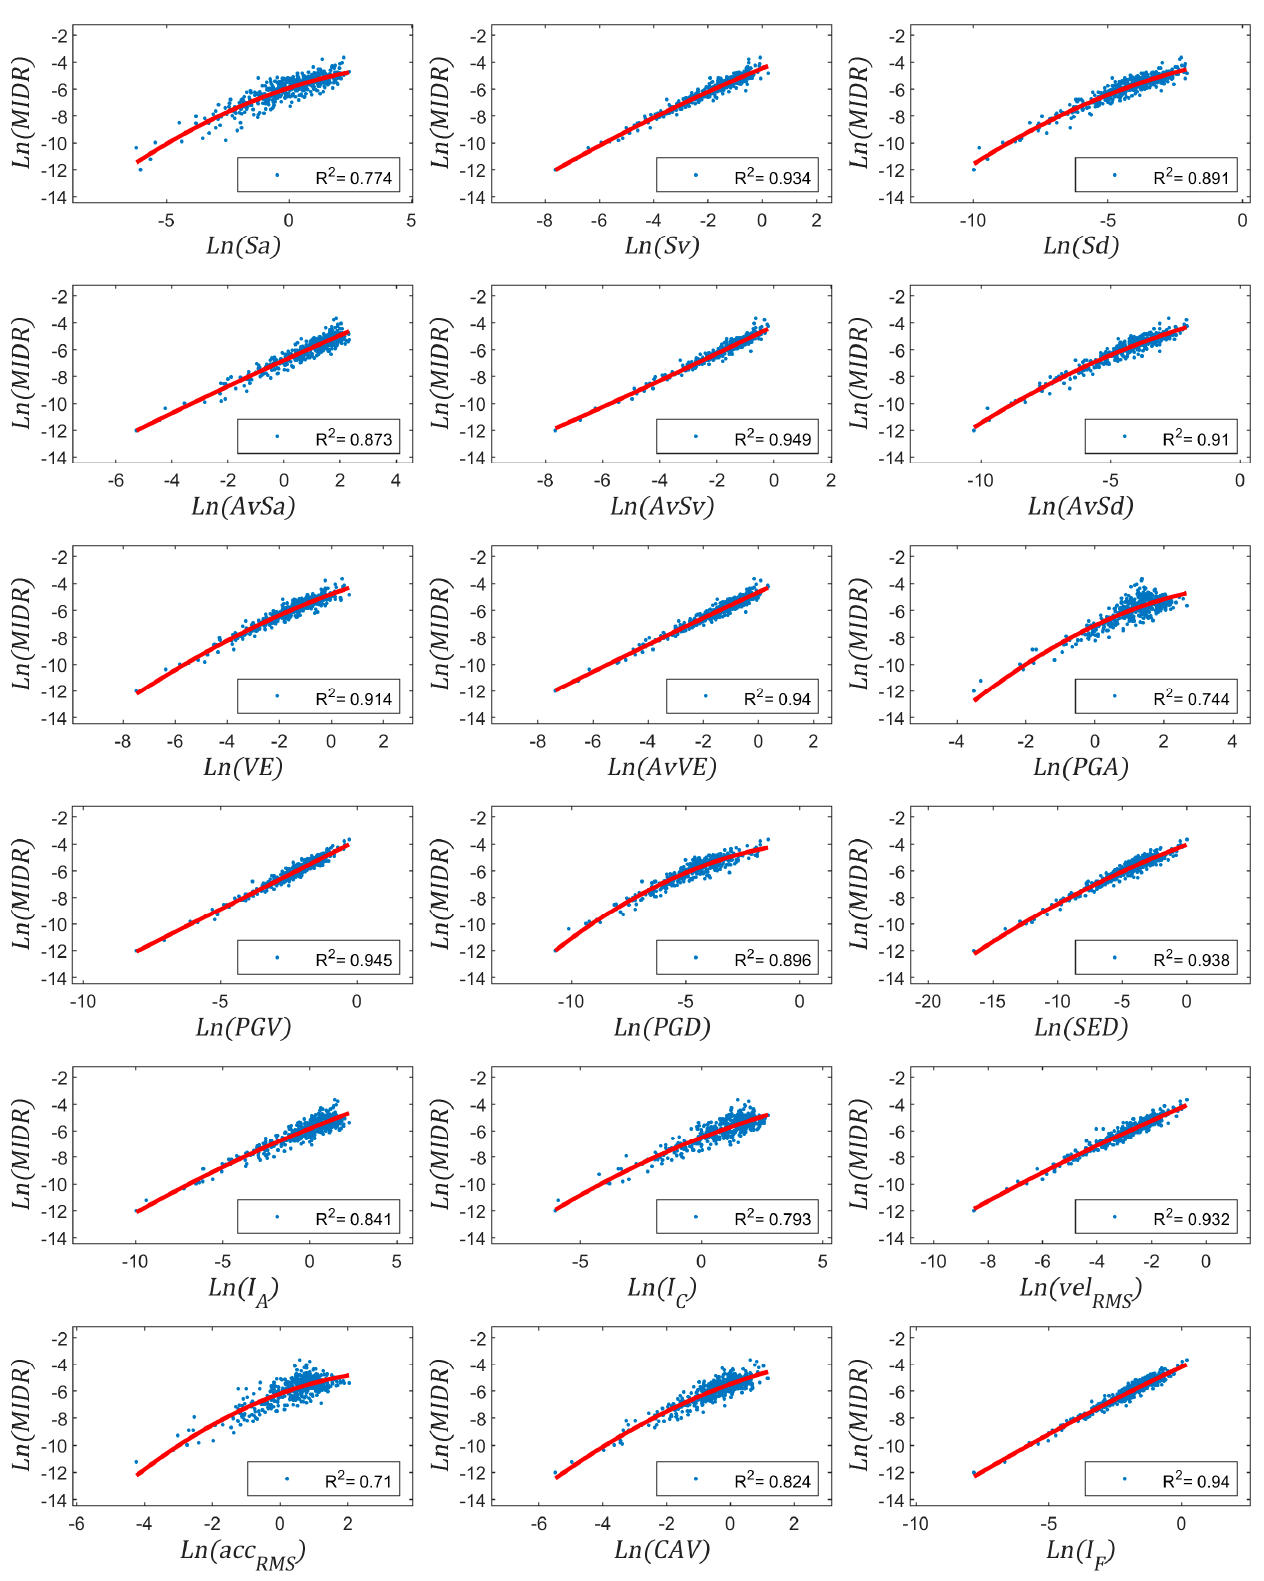
Figure 6. Correlation coefficient between IMs and MIDR in the log-log space for near-fault records.